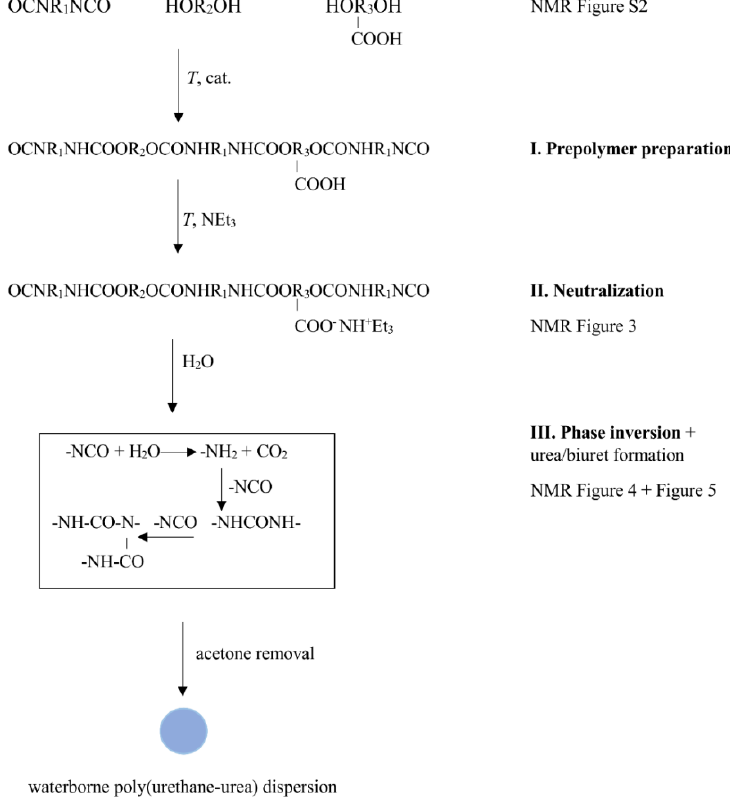
Figure 1. Scheme of waterborne poly(urethane-urea) dispersion preparation.